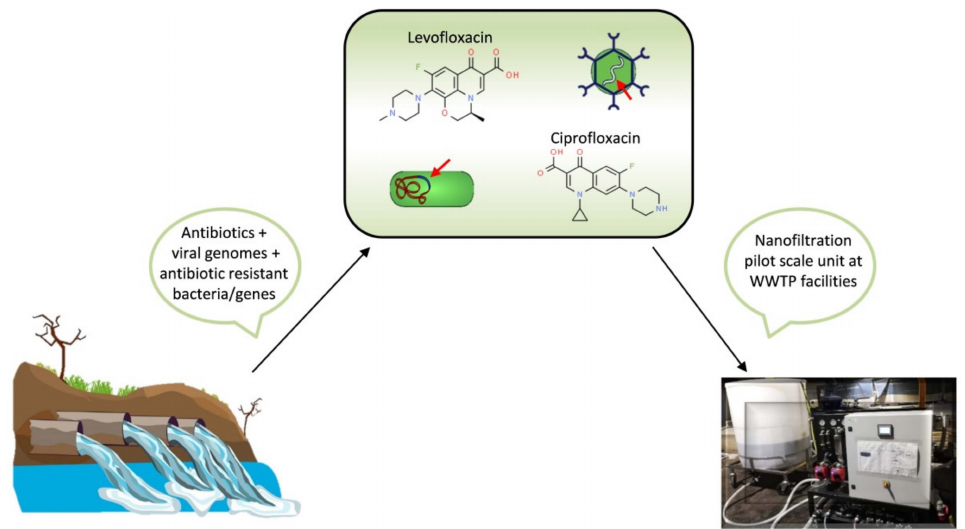
Figure 2. On-site removal of antibiotics, antibiotic resistance genes and viral genomes from a domestic wastewater effluent by a nanofiltration pilot unit. Reprinted with permission from Crist ó v ã o et al. [133]. Copyright,